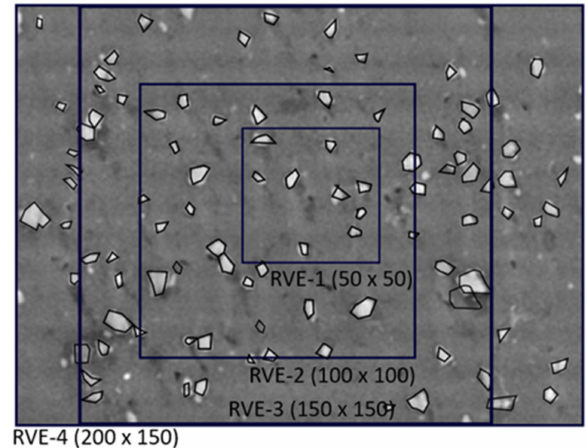
Figure 4. Representation of the RVEs used in the study.